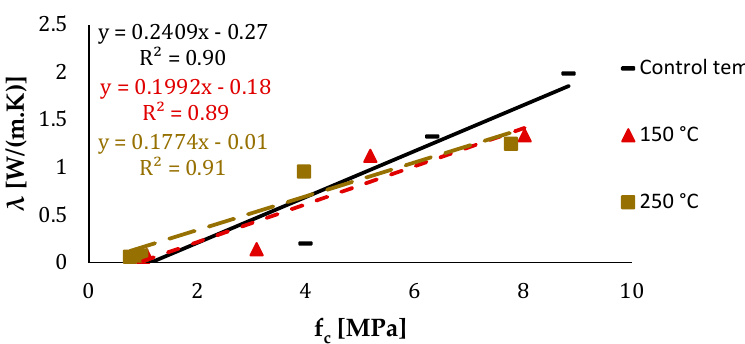
Figure 16. Relationship between compressive strength and thermal conductivity.